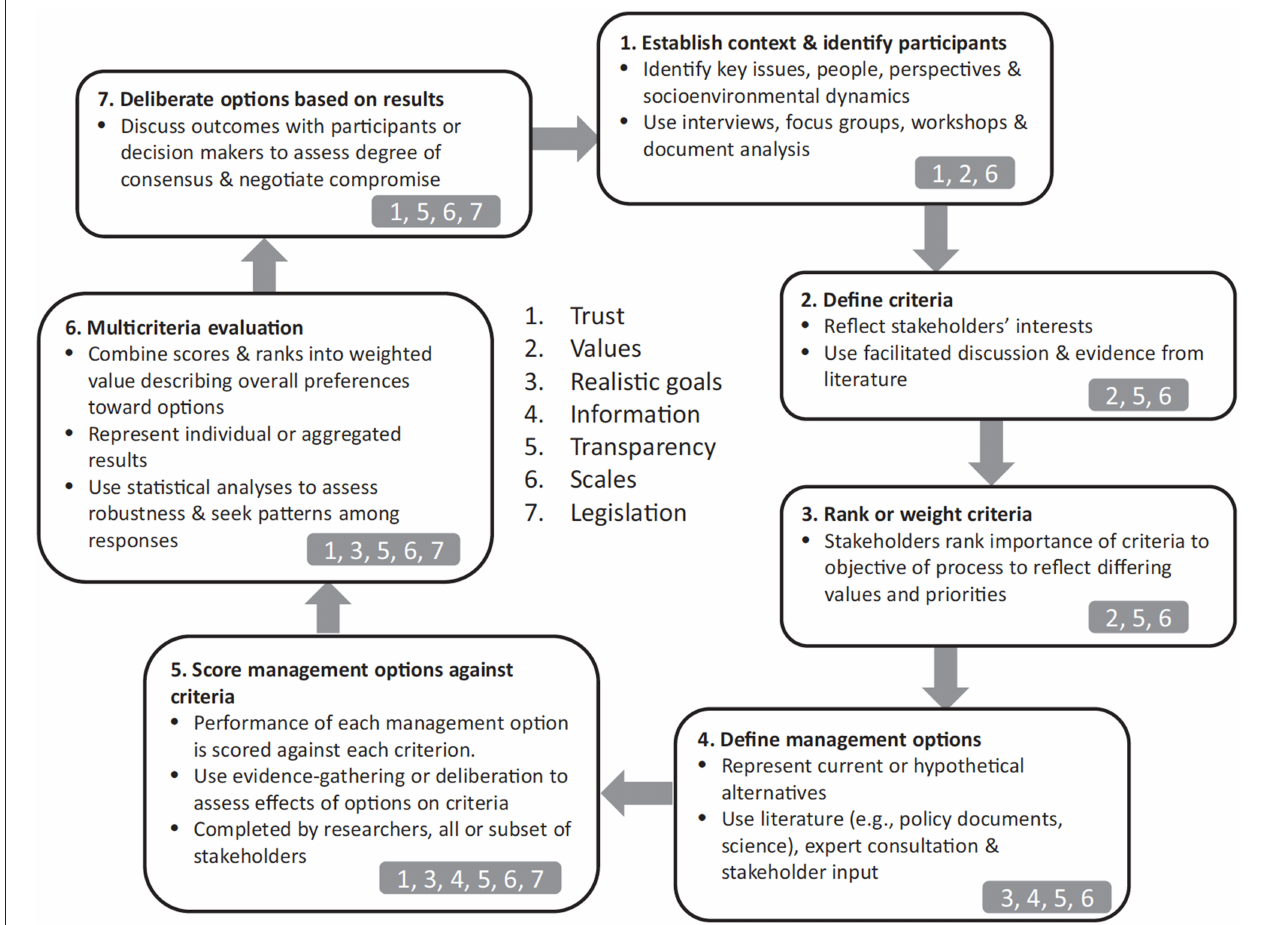
FIGURE 13 | Schematic outline of the seven main stages of participatory multicriteria decision analysis. Key conflict challenges (numbers 1–7 at the center of the chart) can be addressed at multiple stages, and many of these conflicts are dealt with throughout the process, notably issues of scale, and the need for legislative flexibility (Modified from Davies et al.,